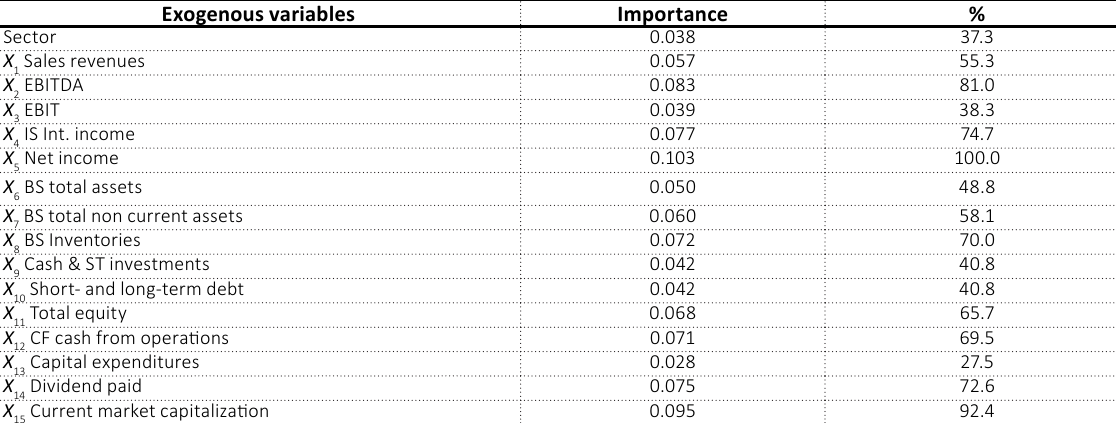
Figure 4. ROC chart for the Moody’s model Table 10. Relative importance of the exogenous variables of the